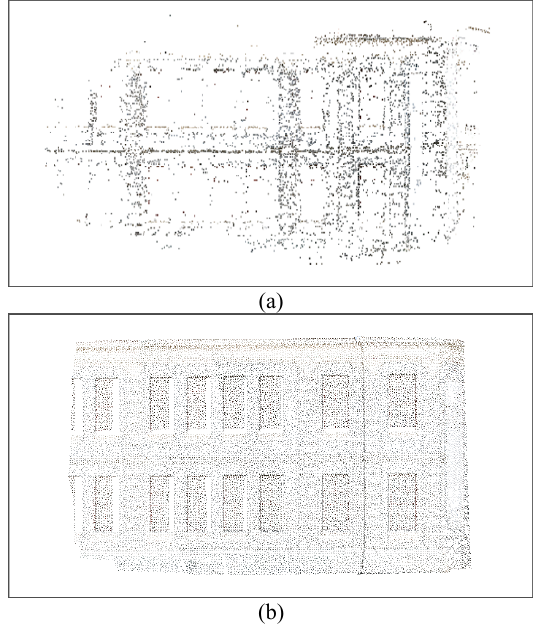
Figure 9 . The input point clouds for dense reconstruction: (a) the sparse point cloud from VisualSFM; (b) the laser point cloud. Figure 11 . The comparison of the dense reconstruction results: (a) visualSFM+ PMVS; (b) the proposed